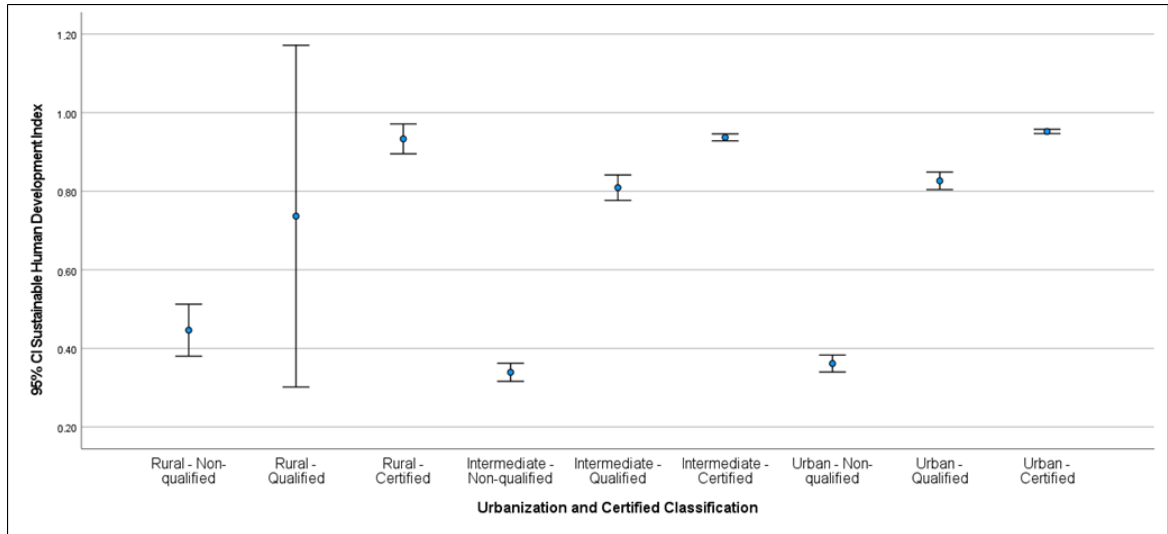
Figure 10. Error bar graph of the municipalities by degree of urbanization and classification of the PMVA.